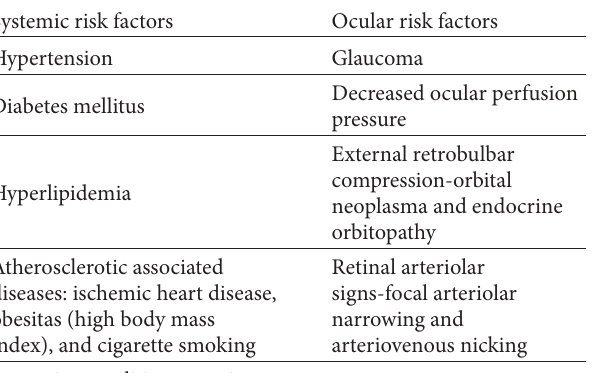
Table 1: Systemic and ocular risk factors for RVO [5,